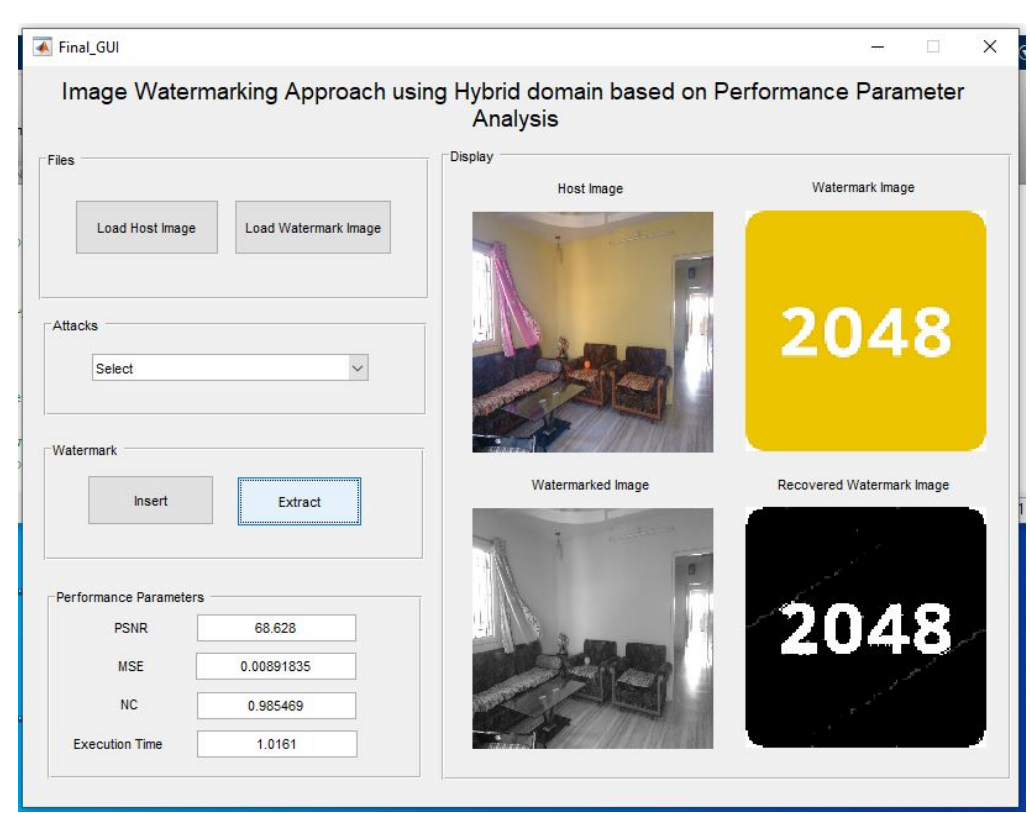
Figure 14. Embedding and Extraction using the proposed method for a real-time host image of size 1200 × 1200. Here, in the Figure 15 first histogram equalization attack is applied on a watermarked image and the watermark is extracted using the proposed method, as shown in the figure.